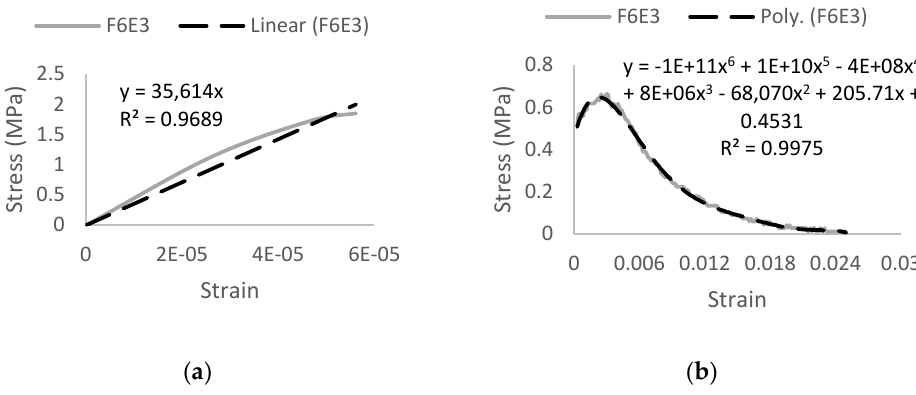
Figure 10. F6E3 uniaxial tension stress – strain curve: ( a ) elastic stage and ( b ) plastic stage.